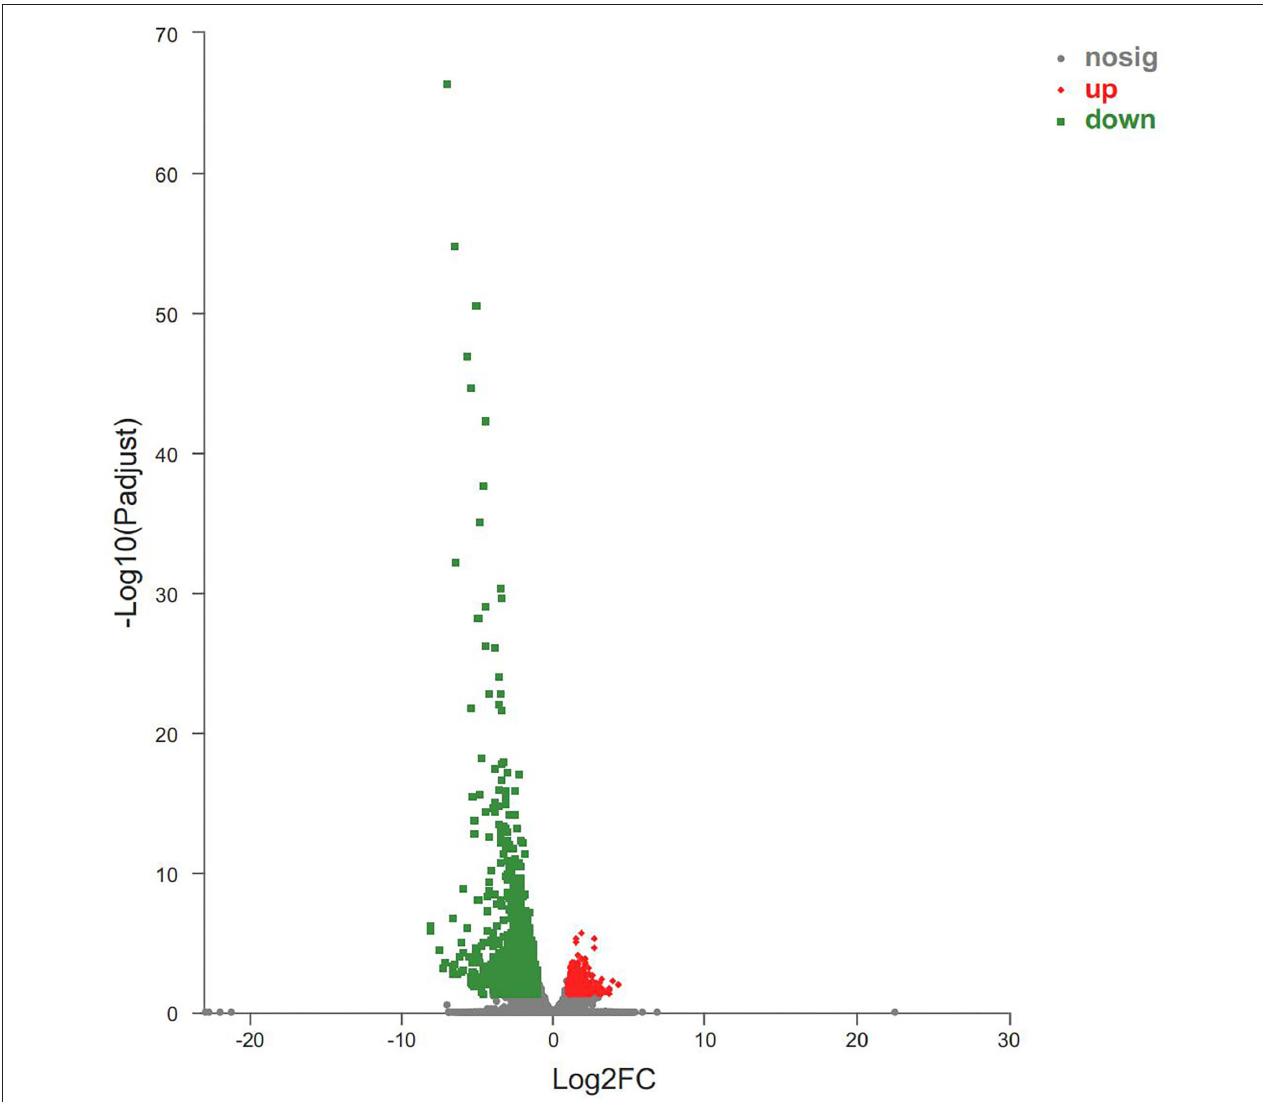
FIGURE 3 | Volcano plot of DEGs between B-PATPHs and B-FATPHs. The x -axis indicates the fold-change, and the y -axis shows the statistically significant differential expression. The red, green, and gray dots represent upregulated unigenes, downregulated unigenes, and the unigenes with no significant changes,